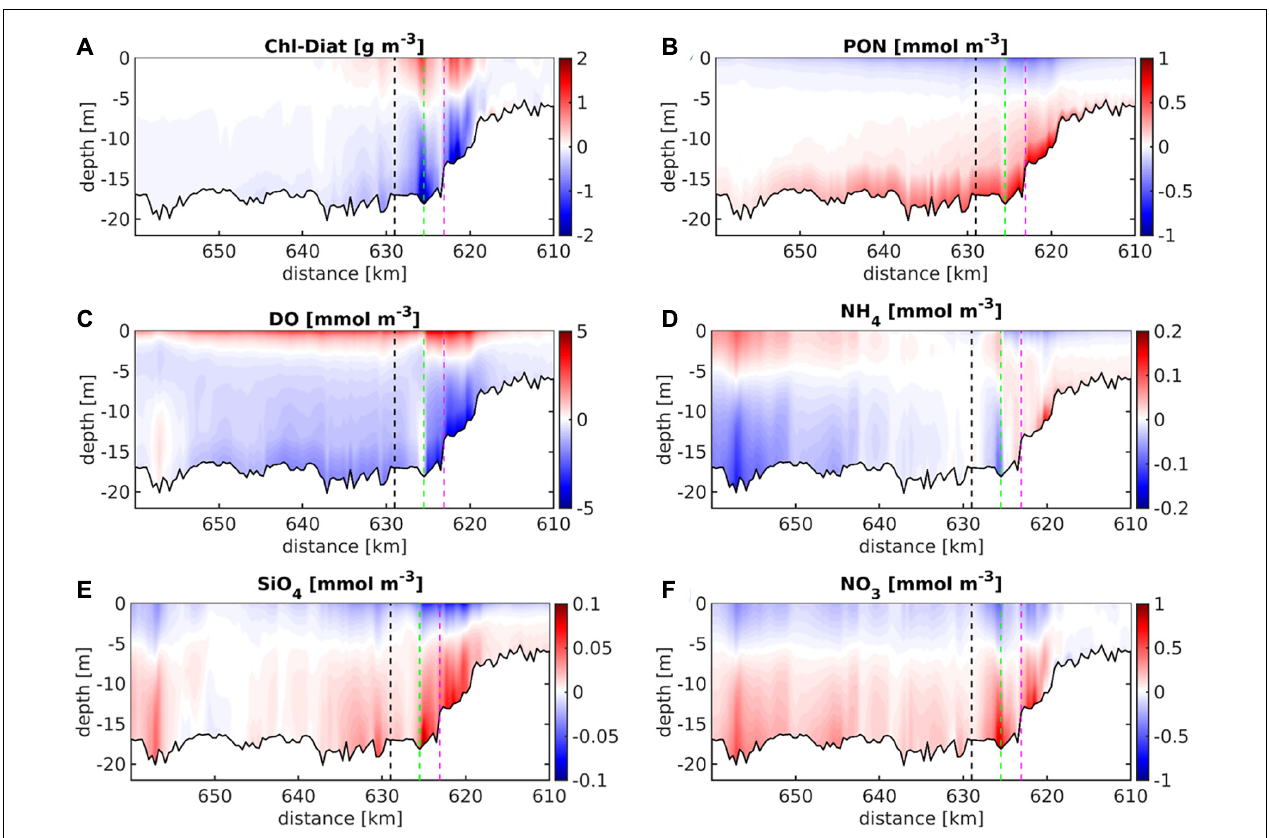
FIGURE 9 | Time-averaged vertical anomalies of (A) chlorophyll, (B) detritus, (C) dissolved oxygen, (D) ammonium, (E) silicate, and (F) nitrate concentrations are given for the main channel between km 610 and km 640 of the Elbe estuary. The time averages represent the simulation during the period of May to September 2012. The dashed black, green, and purple lines mark the positions of station Seemannshöft (“HH,” see Figure 1 ), the confluence of the northern and southern channel branches, and station Sankt Pauli (see inset in Figure 1 ),